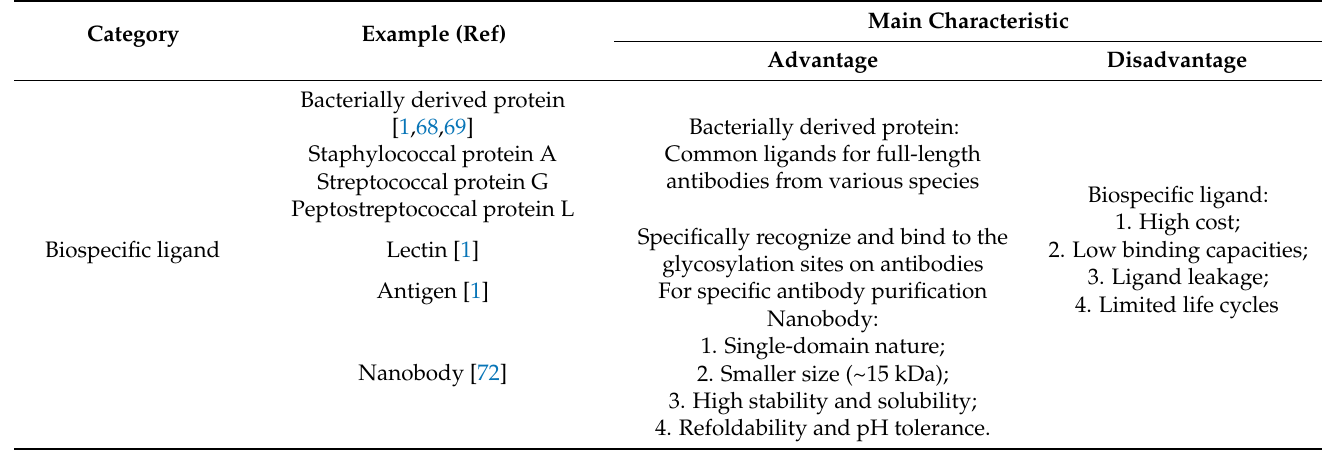
Table 1. Affinity ligands of antibody used in affinity chromatography and their main